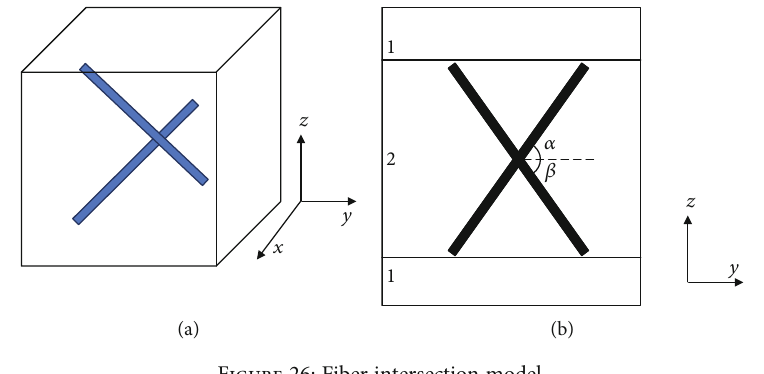
Figure 26: Fiber intersection